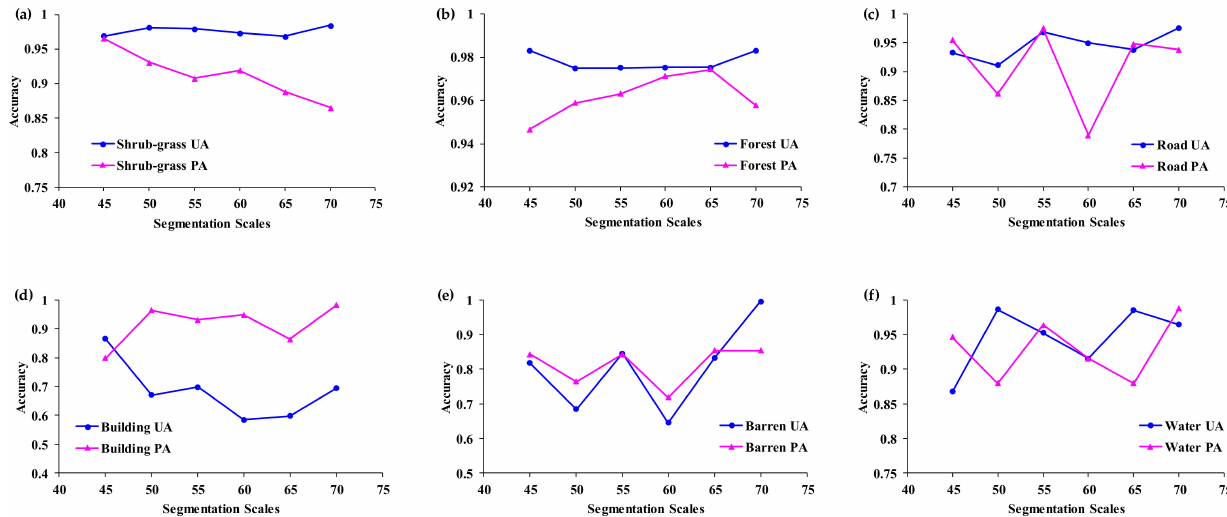
Figure 7. Comparison of the user’s accuracies and producer’s accuracies. ( a ) Shrub-grass; ( b ) Forest; ( c ) Road; ( d ) Building; ( e ) Barren; ( f )